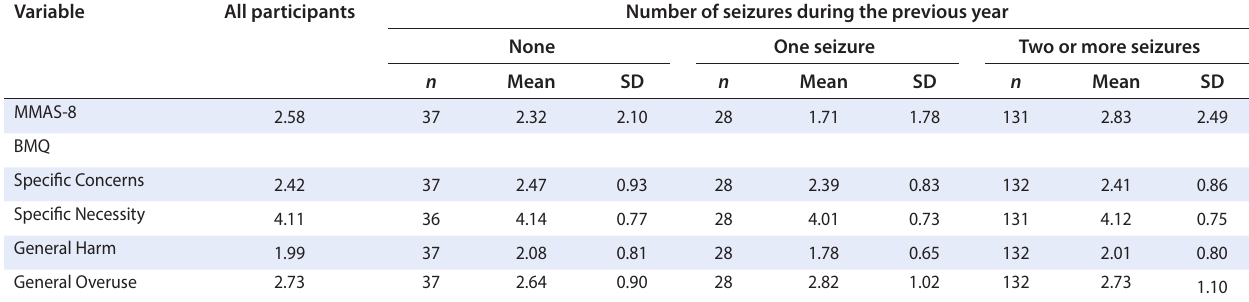
Table 4: Mean MMAS and BMQ values by seizure control Variable